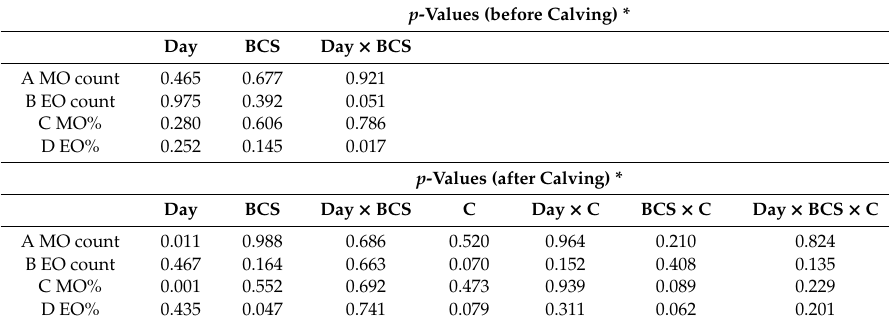
Figure 3. Characteristics of counts of monocytes (MO, ( A )) and eosinophils (EO, ( B )), as well as of percentages of MO ( C ) and EO ( D ) in the course of the experiment. Ante partum , cows were categorized in high body condition score (BCS, BCS H ) and adequate BCS (BCS A ). Post partum, the two groups were subdivided again, each into a group with a concentrate proportion of 60% (C 60, solid line) in the ration (increasing from 35–60% during the first three weeks after calving) and a group with a concentrate proportion of 35% (C 35 , dashed line) in the ration. Thus, four groups emerged: BCS H / C 60 ( n = 15), BCS H / C 35 ( n = 15), BCS A / C 60 ( n = 15), BCS A / C 35 ( n = 15). Table 2. Model corresponding to Figure 3. p -Values (before Calving) *